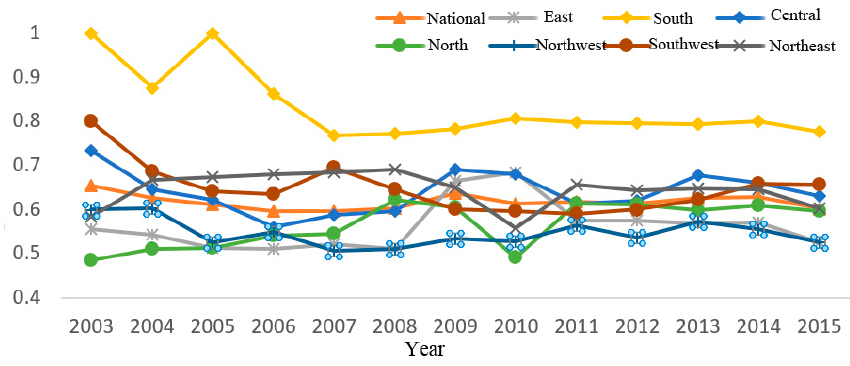
Figure 1. Average land use eco-efficiency in China from 2003 to 2015.